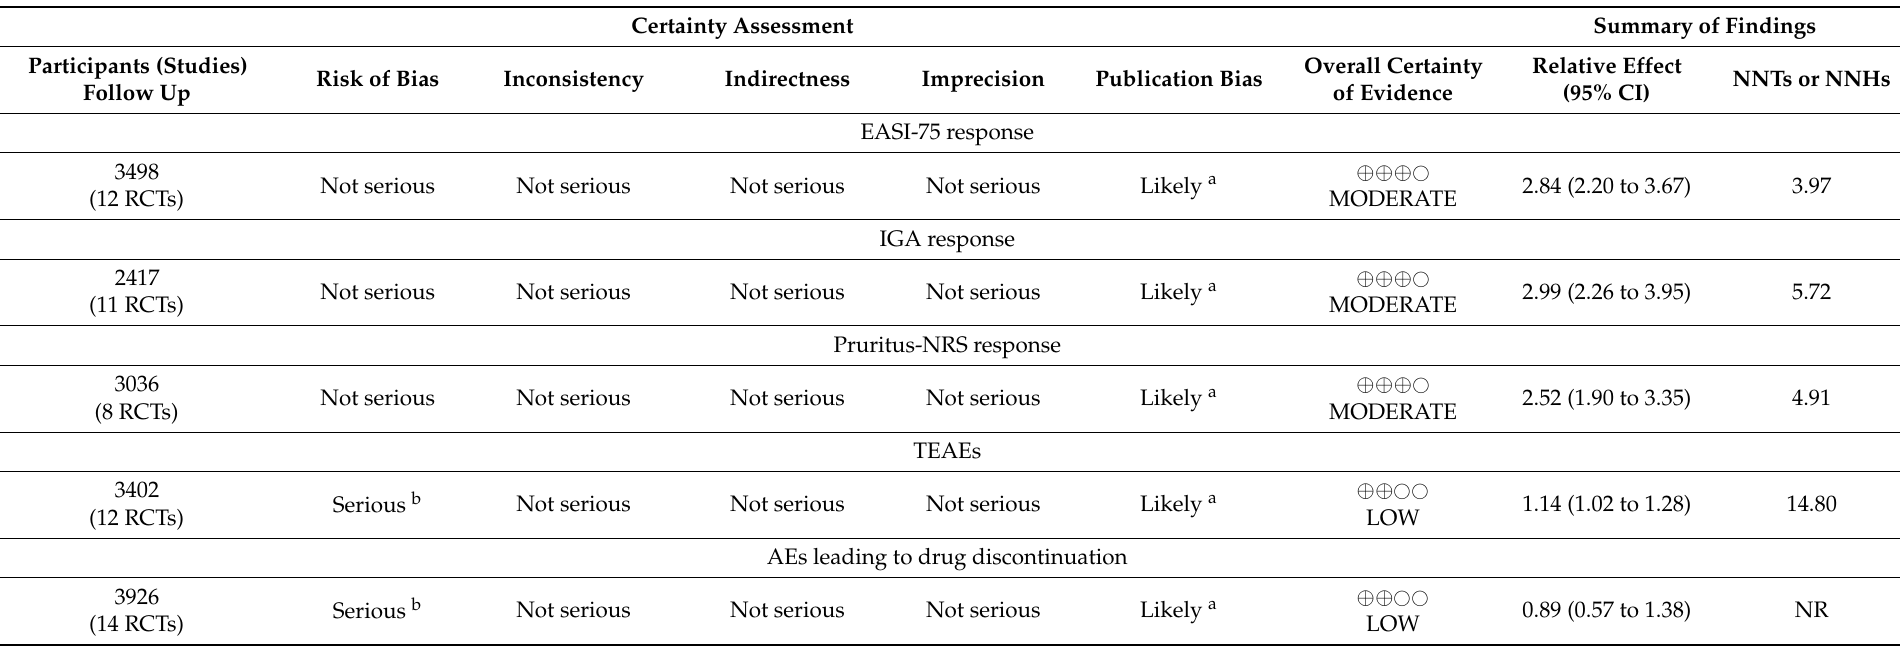
Table 4. Certainty of evidence based on GRADE (Janus kinase inhibitors vs. placebo in atopic dermatitis). Certainty Assessment Summary of